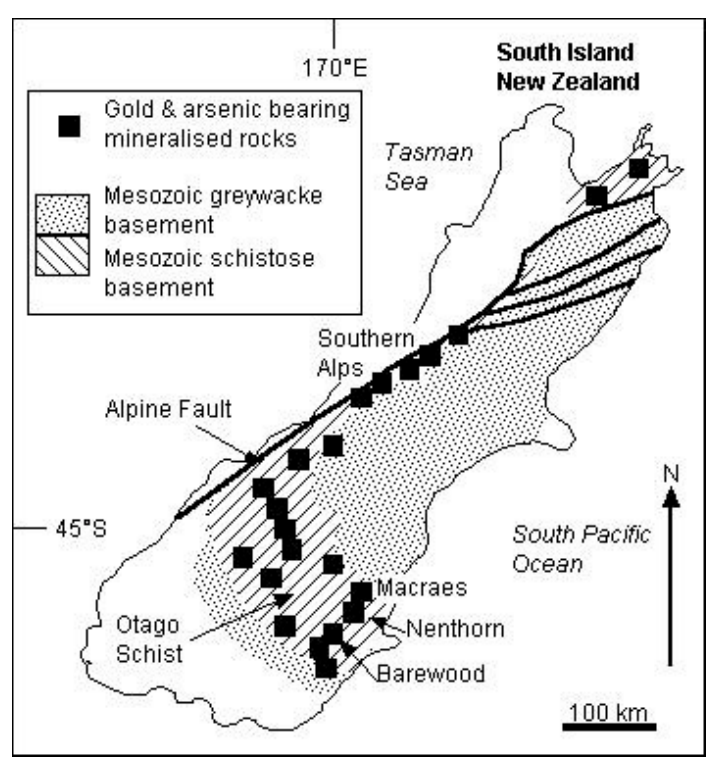
FIGURE 1. Geological map of the South Island of New Zealand, showing the locations of mineralised systems[8], including the sites examined in this study (Macraes, Nenthorn, Barewood) in the Otago Schist. The study area lies in a rain shadow to the east of the actively rising Southern